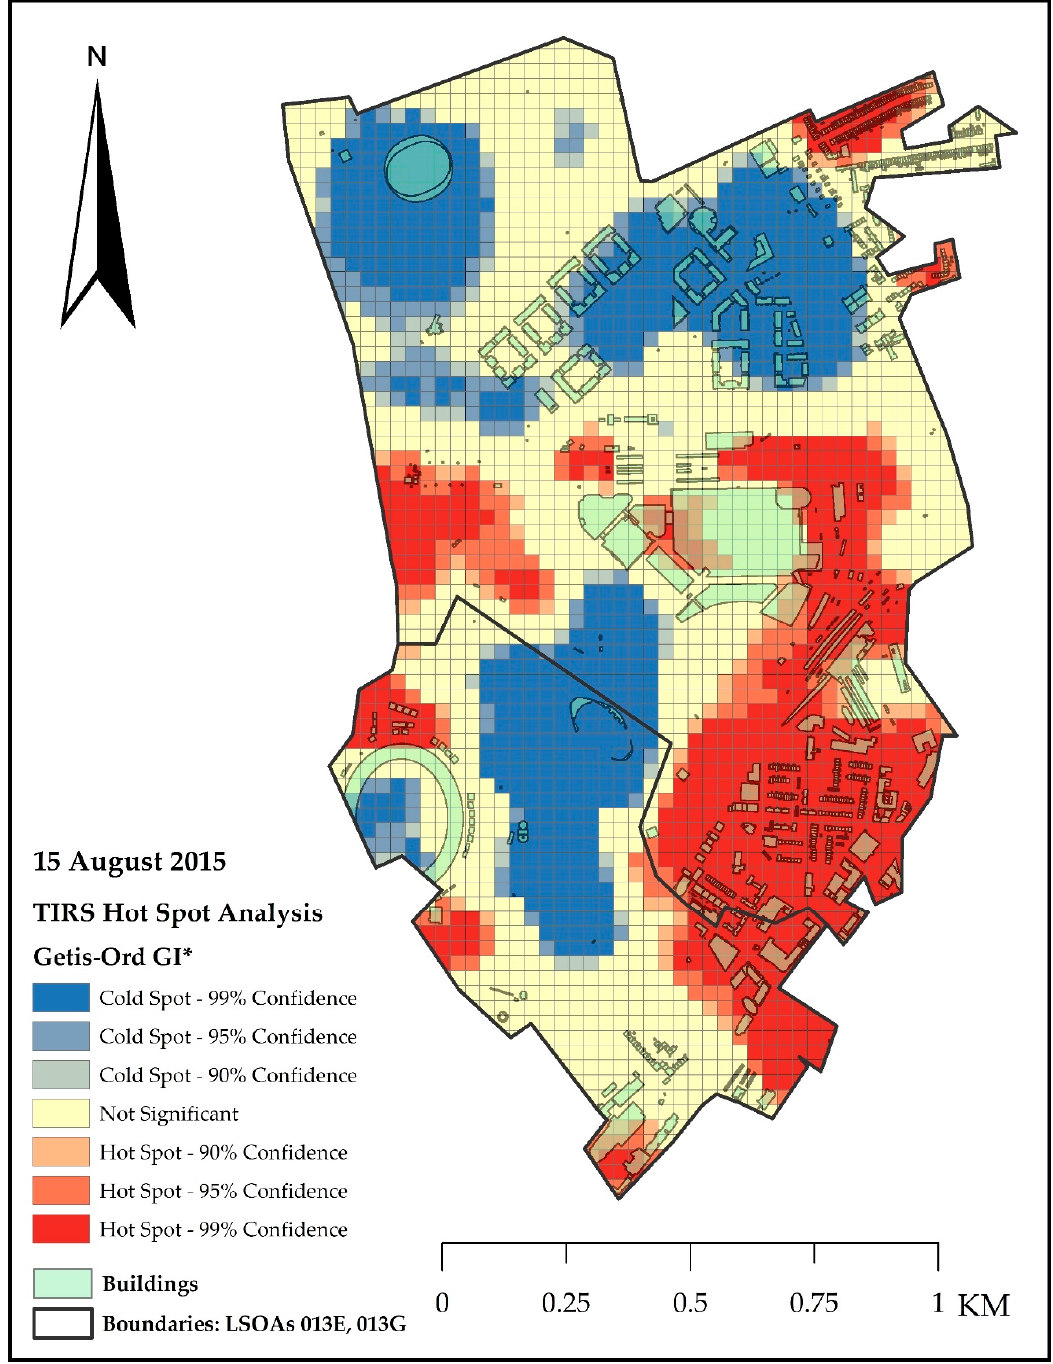
Figure 12. Hot spot results of temperature cluster analysis for LSOAs 013E and 013G, calculated from 15 August 2015 Landsat 8 TIRS image, overlain by buildings polygons. Contains National Statistics data © Crown copyright and database right (2015) and (2012). Contains Ordnance Survey data © Crown Copyright and database right [2015/2012], and also OS VectorMap ® Local [SHAPE geospatial data], Scale 1:10,000, Tiles: tq38ne, tq38se. Updated: 1 April 2016, Ordnance Survey (GB), Using: EDINA Digimap Ordnance Survey Service, <http://digimap.edina.ac.uk>, Downloaded: 8 December 2016 17:58:35.615.